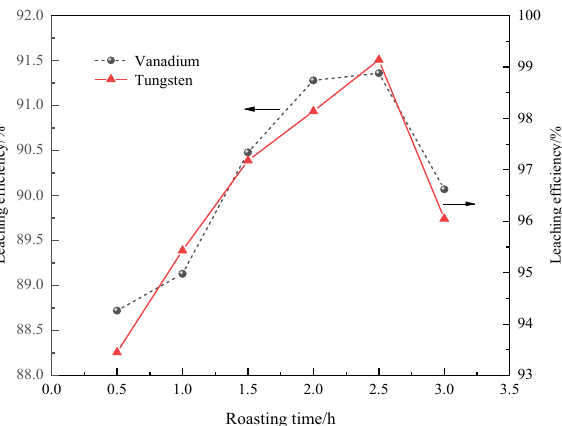
Figure 5. The effect of roasting time on the leaching efficiencies of V and W.